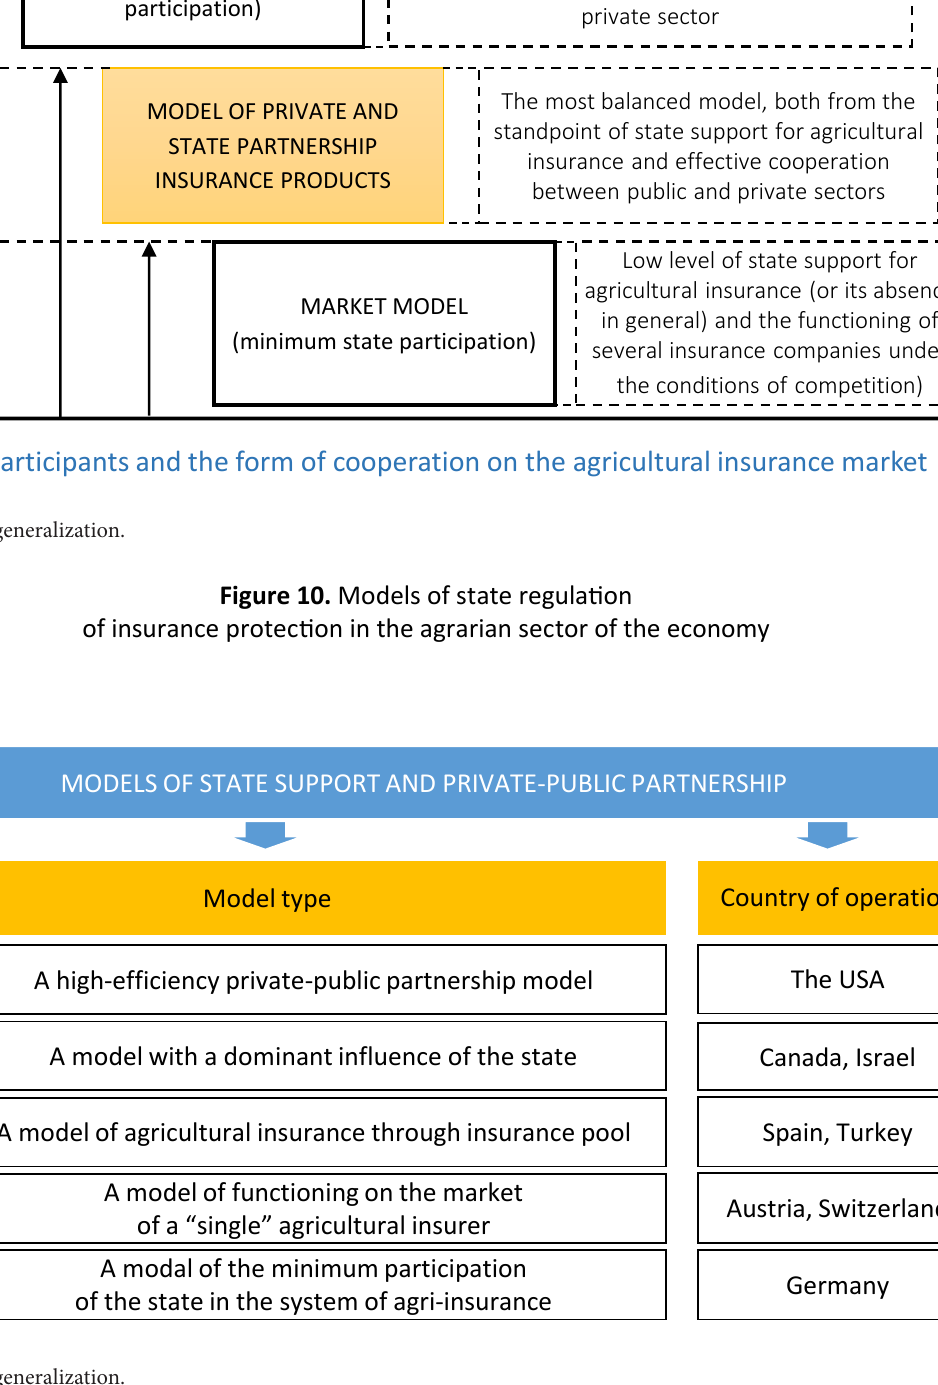
Figure 11. Typical characteristics of state support